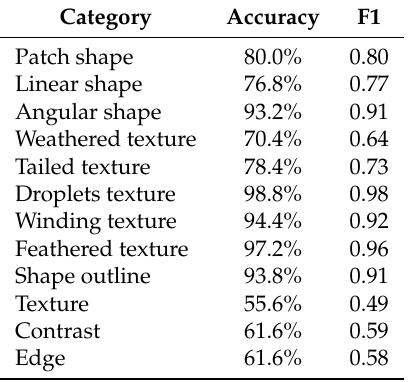
Table 8. Classification accuracy and F1 score for each one of the 12 categories on the validation